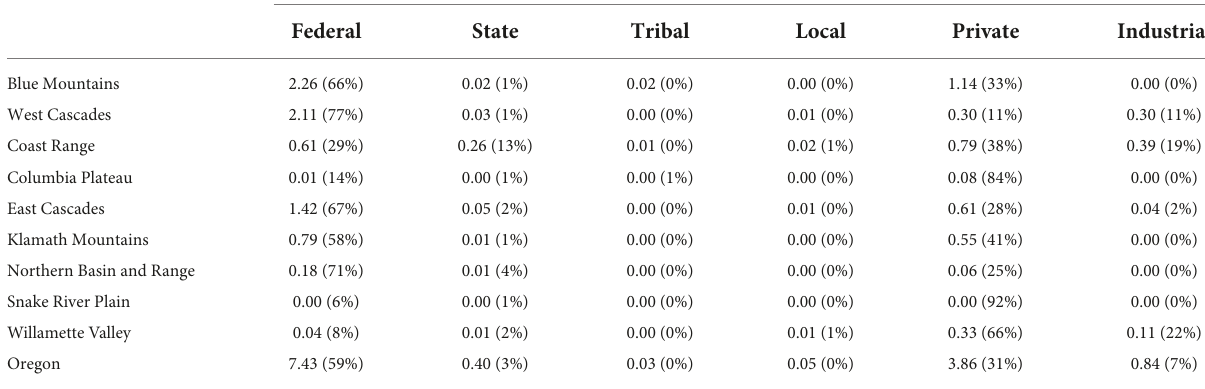
TABLE 2 Current forestland ownership and management within each ecoregion and overall for Oregon.